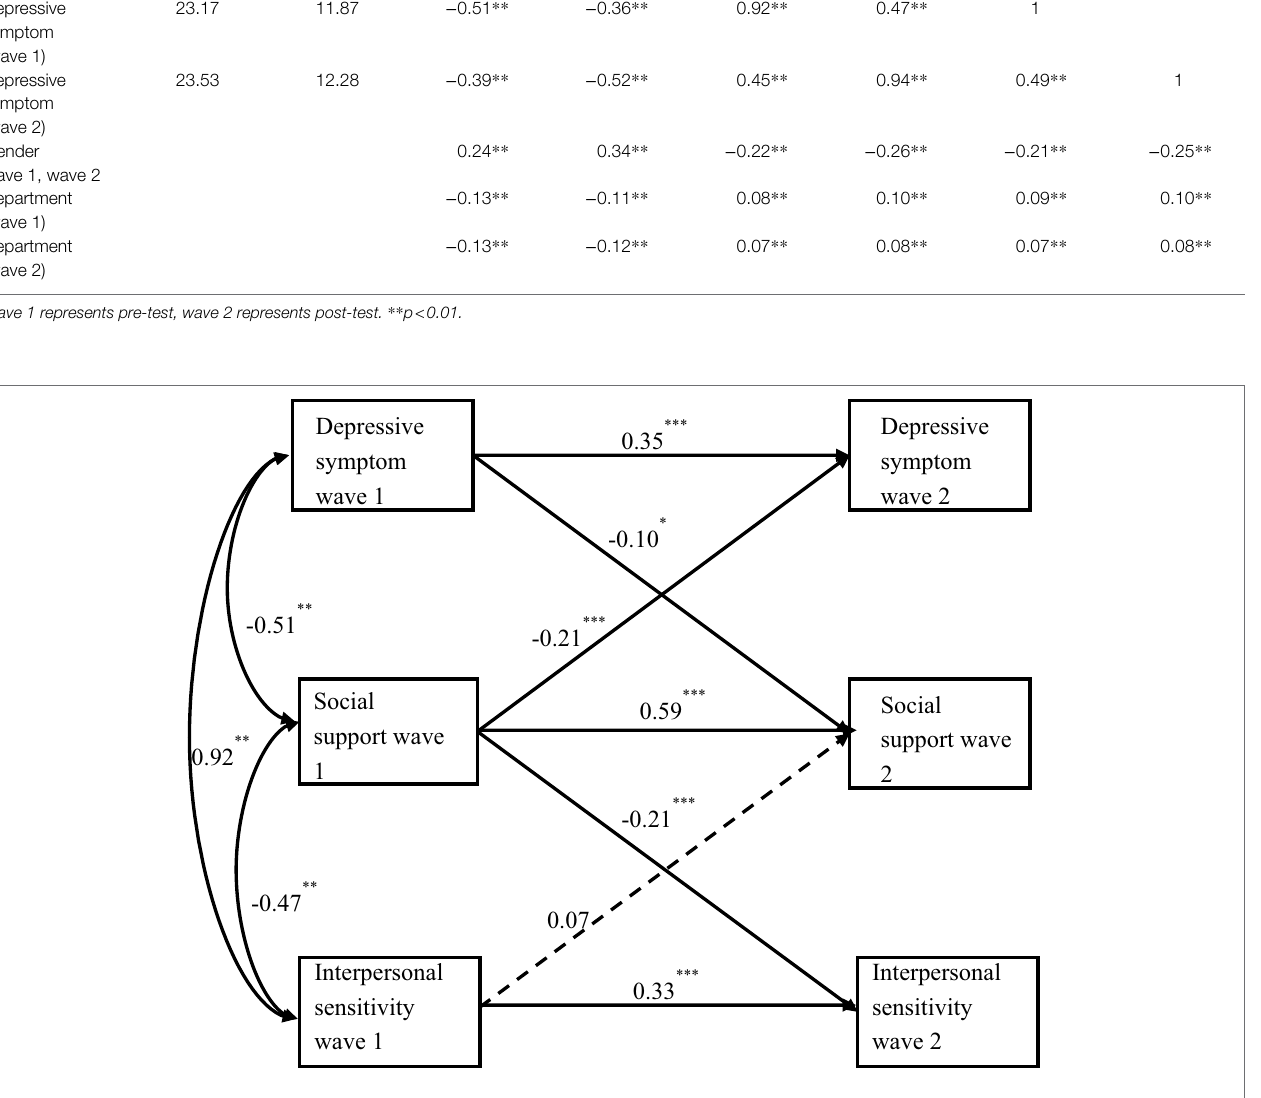
FIGURE 1 | Standardized path coefficient of cross-lag model. One-way arrows with dotted lines represent paths with no significant relationship between two variables. Single arrows with solid lines indicate the path after the crossing; Double arrows indicate the concurrent covariance within the wave 1 variable. The figure does not show the concurrency covariance within the wave 2 variable. Wave 1 = Baseline, wave 2 = 1 year later. * p < 0.05, ** p < 0.01, and *** p <